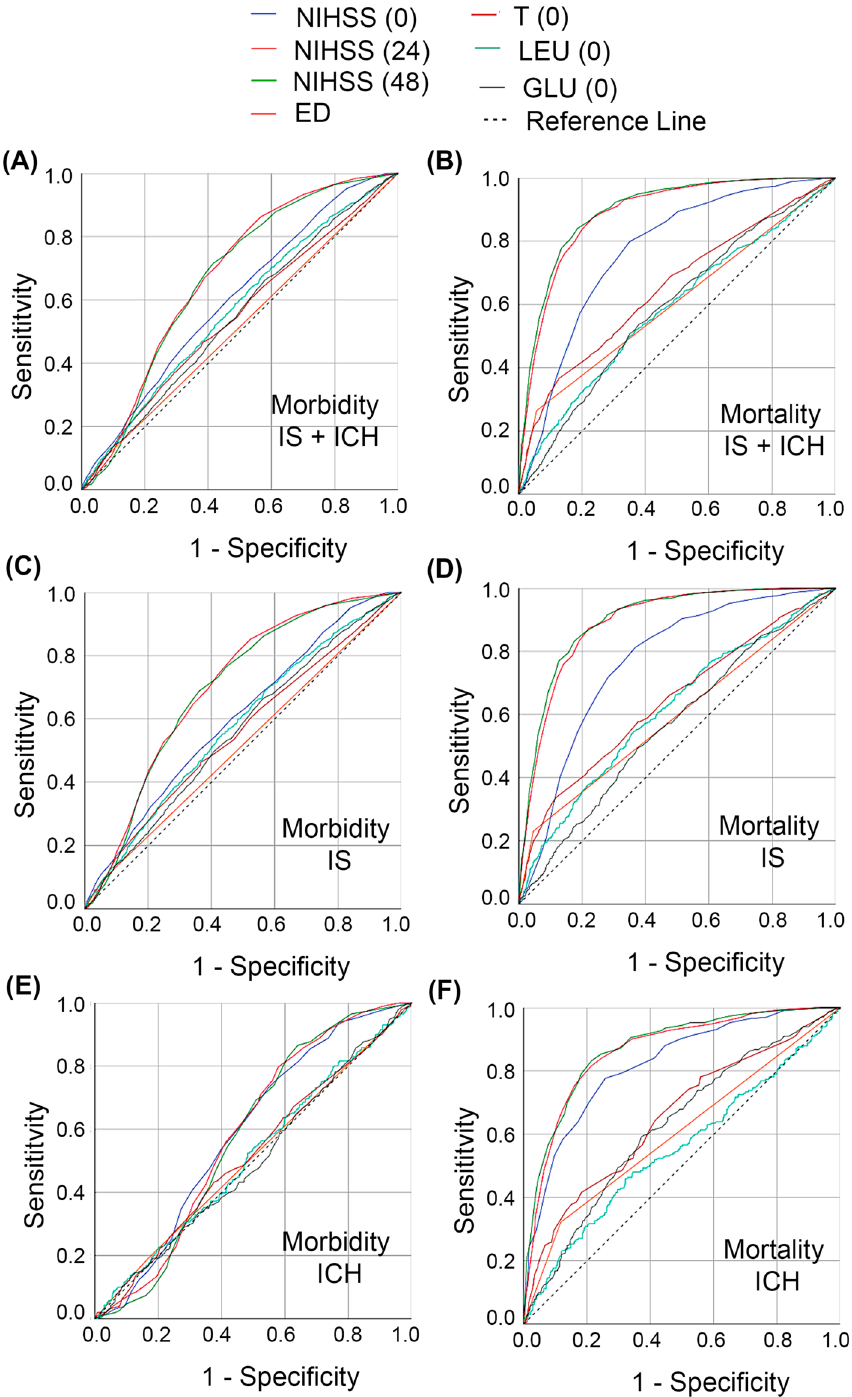
Figure 5. Comparison of ROC curves of 7 variables selected for machine learning experiments for mortality and morbidity prediction at 3 months of the different patient groups evaluated. ( A,B ) Morbidity and mortality of IS + ICH group. ( C,D ) Morbidity and mortality of IS group. ( E–F ) Morbidity and mortality of ICH